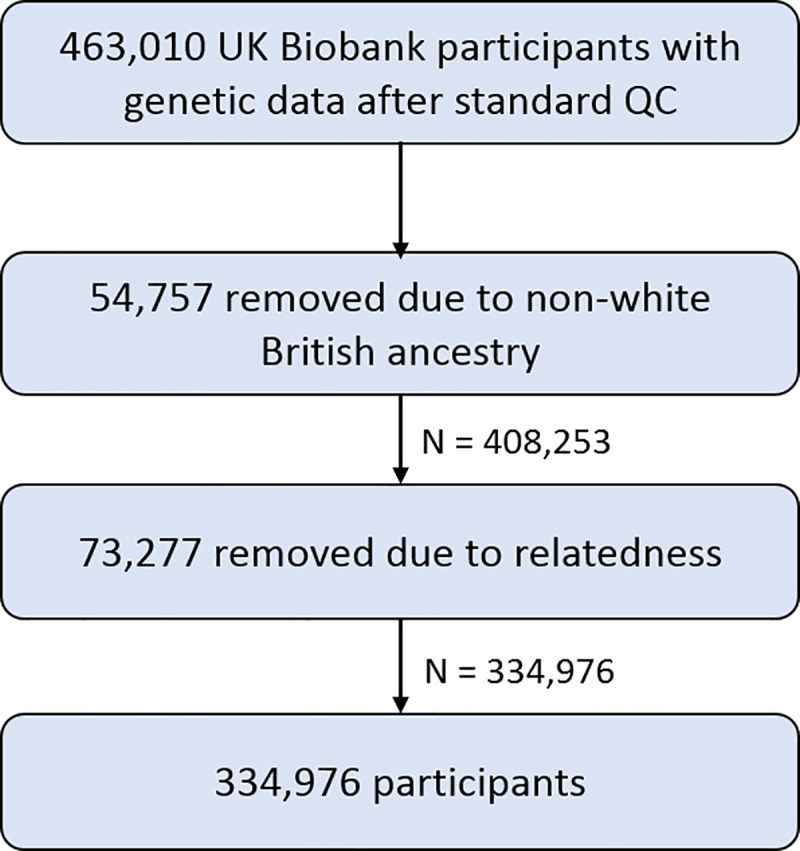
Overview of study sample derivation.Participants with withdrawn consent, sex mismatch or sex aneuploidy were already removed from the dataset in standard QC steps. [49].